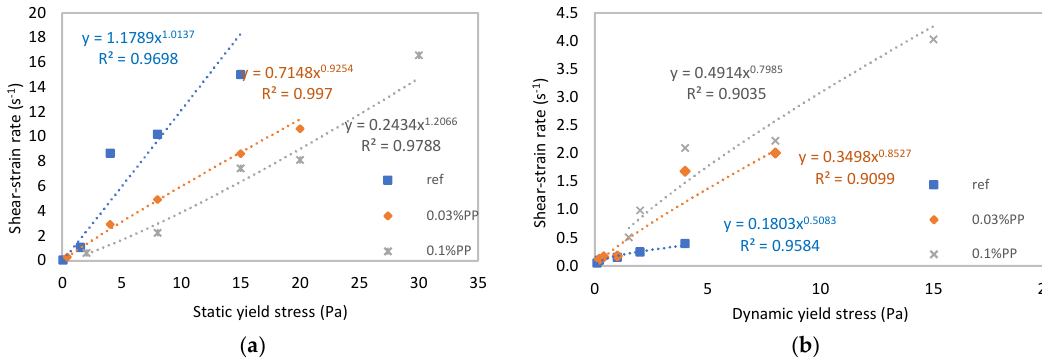
Figure 12. Corrеlation bеtwееn the shear–strain ratе rangе and ( a ) static yiеld strеss, ( b ) dynamic yiеld strеss.